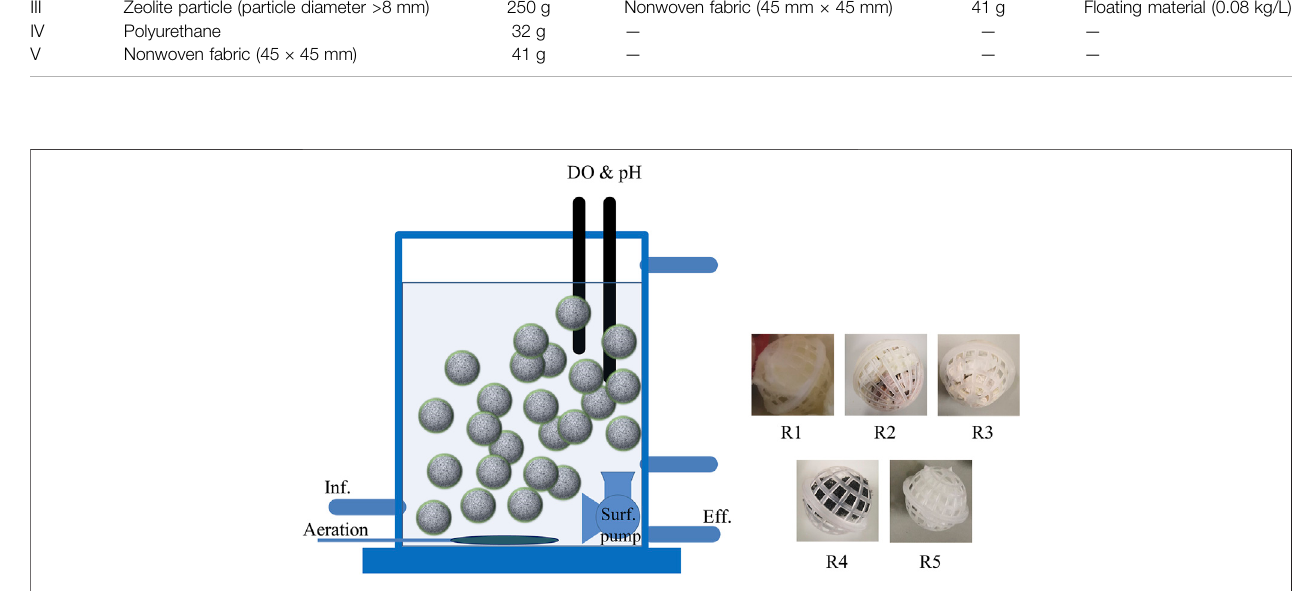
FIGURE 1 | Schematic diagram of the sequencing batch reactor.